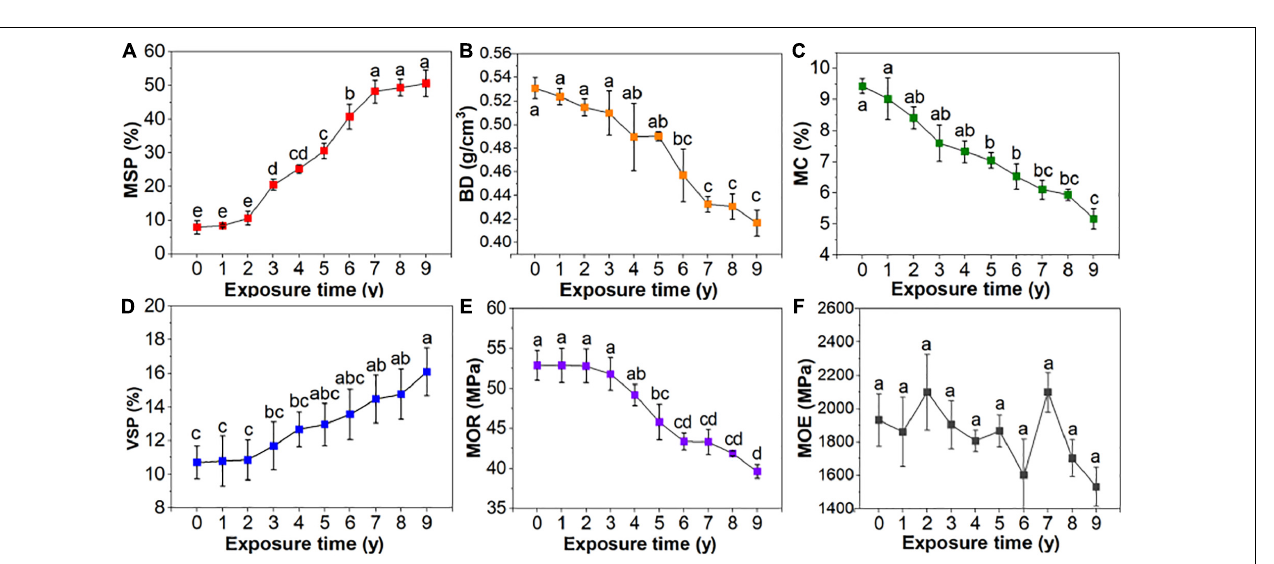
from the macroscopic visual observations that the environmental conditions significantly affected the S. psammophila sand